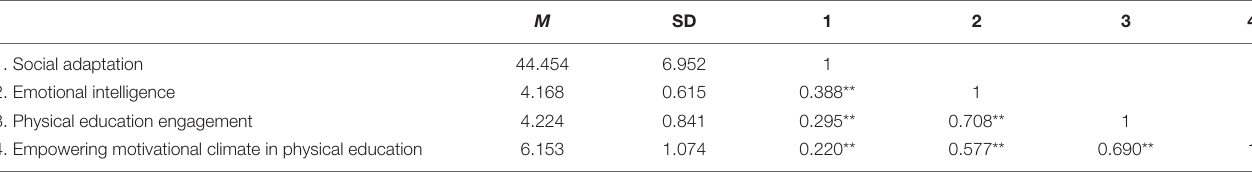
TABLE 1 | Average, standard deviation, and correlation coefficient of each variable.